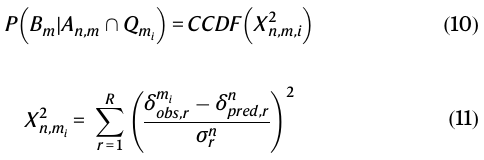
(Table 1). Chemical shift prediction errors for H, N, C α , C β , and CO